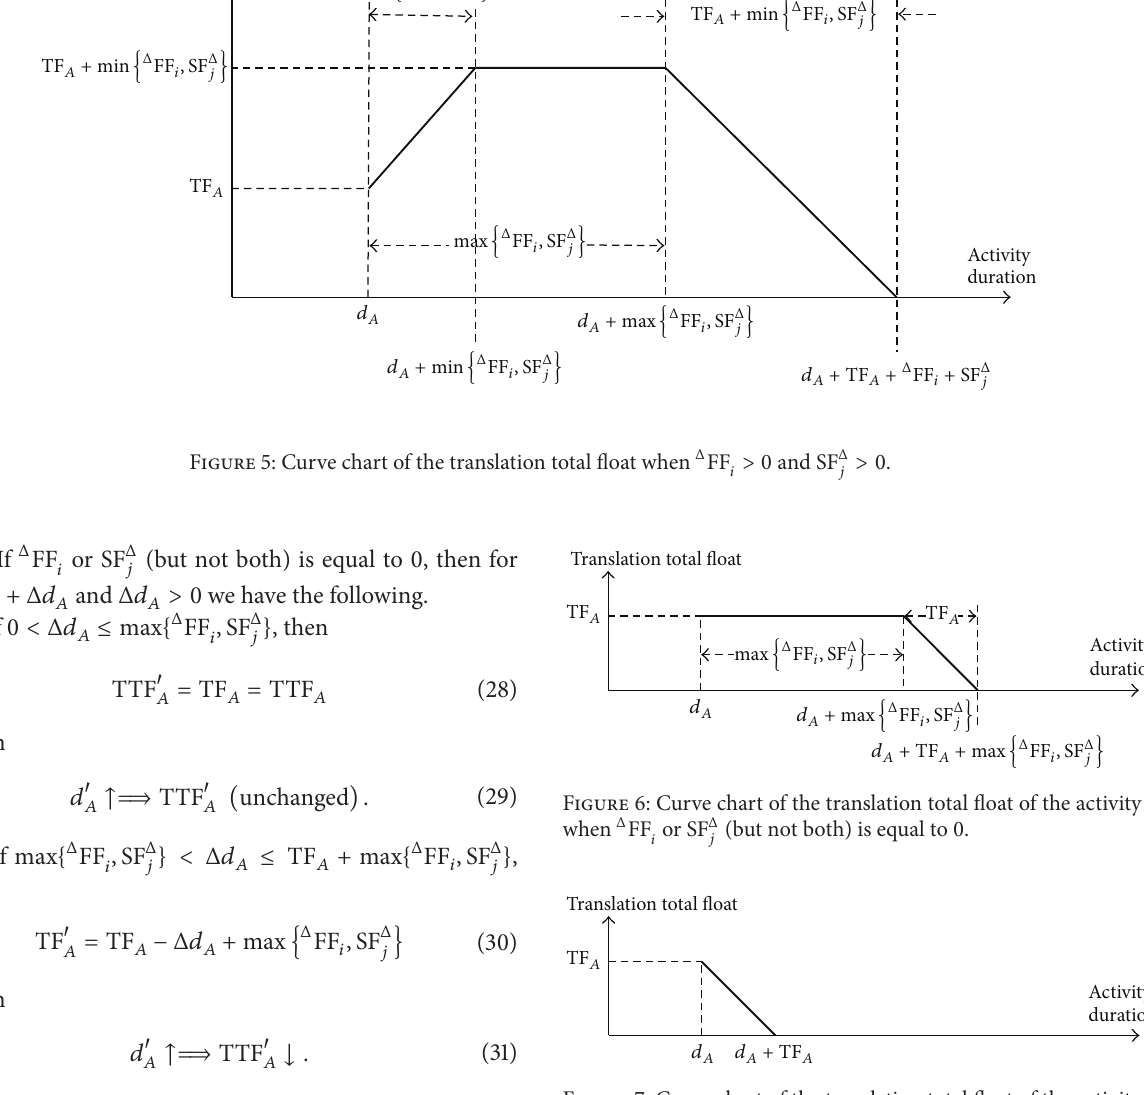
Figure 7: Curve chart of the translation total float of the activity 𝐴 when Δ FF 𝑖 = 0 and SF Δ 𝑗 = 0